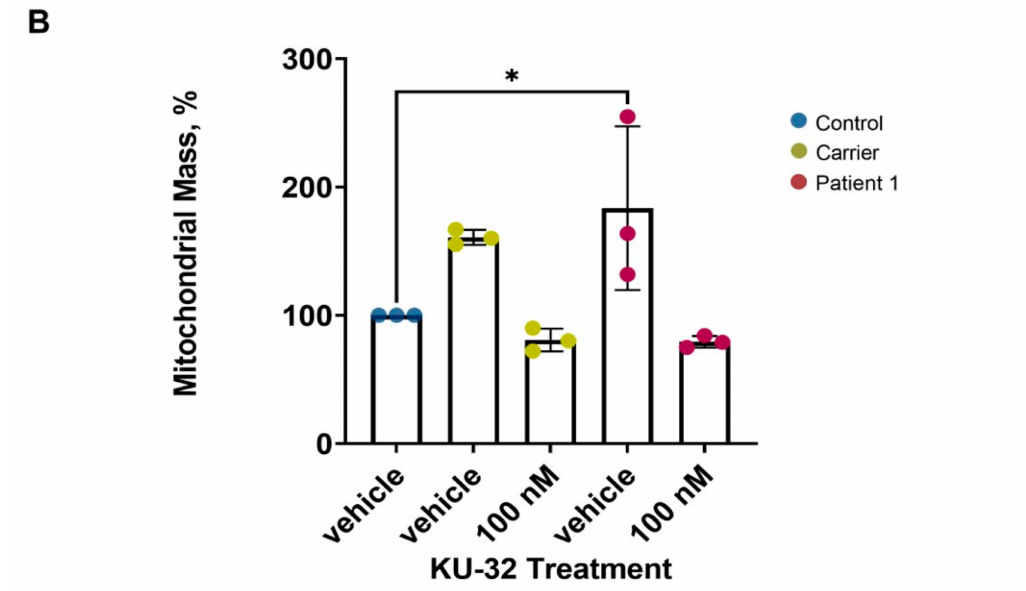
Figure 3. ARSACS patient fibroblasts show an increased mitochondrial volume compared to control, which was re- duced upon 100 nM KU-32 treatment. ( A ) The micrographs show the mitochondrial staining (TMRM; red) and the double staining with the cell body (Calcein Blue; blue). ( B ) The histogram represents the calculation of the mitochondrial mass compared to the total volume of the cell body as a percentage. (Carrier vehicle, 160 ± 5.8; Carrier 100 nM KU-32, 80.8 ± 9; Patient 1 vehicle, 184 ± 63; and Patient 1 100 nM KU-32, 79.4 ± 4.5). * p ≤ 0.05. Scale bar = 20 µ